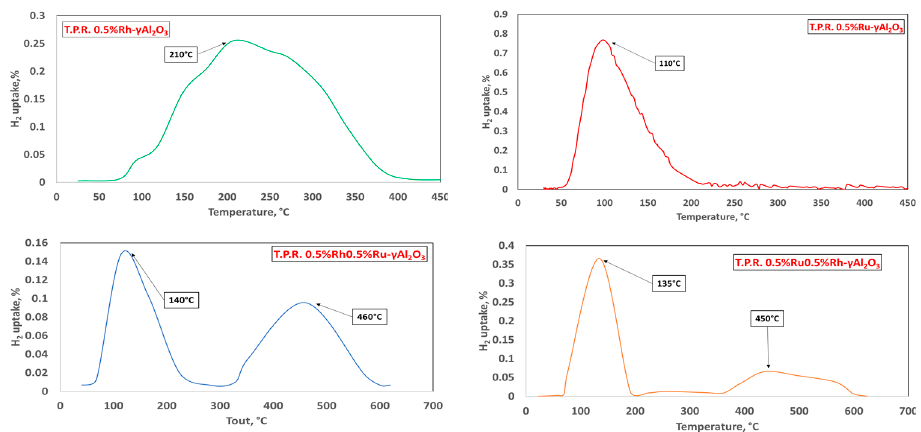
Figure 7. Catalysts’ H 2 -Temperature Programmed Analysis charts.